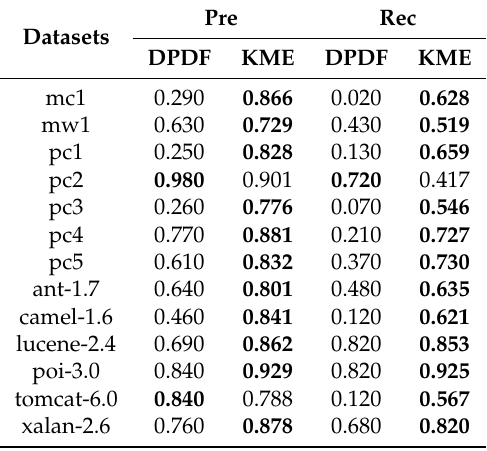
Table 8. Comparison between defect prediction based on deep forest (DPDF) [38] and